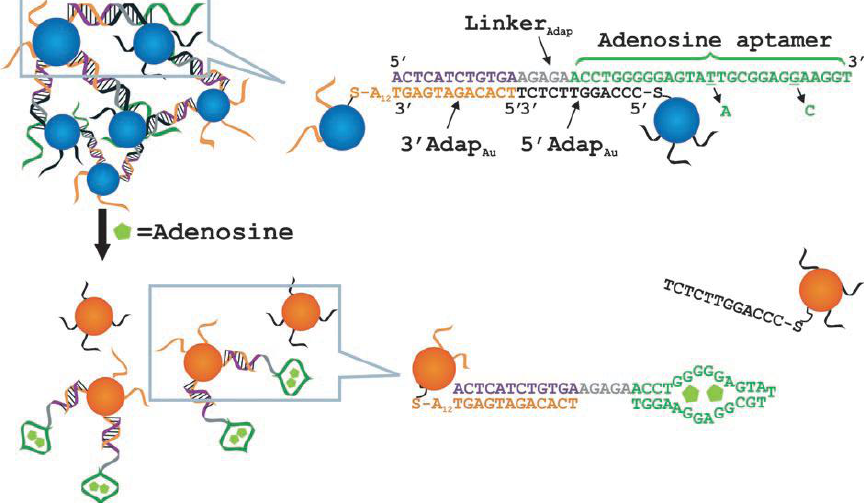
Figure 1. Schematic representation of colorimetric detection of adenosine. The DNA sequences are shown in the right side of the figure. The A polyadenine chain. In a control experiment, a mutated linker with the two mutations shown by the two short black arrows was used. Reprinted with permission from Reference